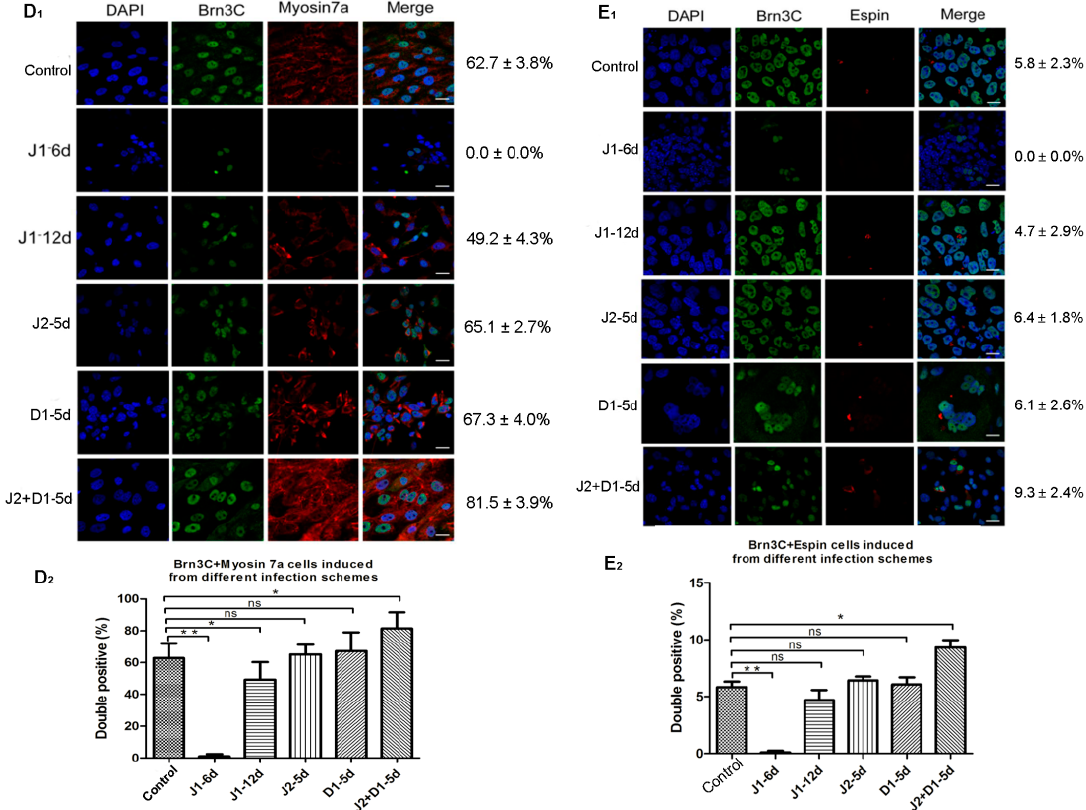
Figure 3. Analysis of hair cell- and supporting cell-specific markers in cells from six infection schemes. ( A ) RT-PCR analyses for the expression of markers specific for hair cells (Myosin7a, Brn3c, Atoh1, and Espin) and supporting cells (P27 kip1 ) in cells from six infection schemes. ( B ) Semi-quantitative analysis of the expression of specific genes using Image J and GraphPad. Expression values are relative to those of GAPDH and are presented as the mean ± SD ( n = 3). * indicates p < 0.05; ** indicates p < 0.01. ( C 1 ) Co-expression of Atoh1 (red) and Brn3c (green) in cells induced from six infection schemes. Scale bar: 20 µ m. ( C 2 ) Percentage of Brn3C/Atoh1 double-positive cells in total cells induced using different infection schemes. Error bars represent the SD ( n = 5). ( D 1 ) Co-expression of Myosin7a (red) and Brn3c (green) in cells induced using the six infection schemes. Scale bar: 20 µ m. ( D 2 ) Co-expression of Brn3C and Myosin 7a in total cells induced using the different infection schemes. Error bars represent the SD ( n = 5). ( E 1 ) Co-expression of Espin (red) and Brn3c (green) in cells induced using the six infection schemes. Scale bar: 20 µ m. ( E 2 ) Percentage of Brn3C/Espin double-positive cells in total cells induced using the different infection schemes. Error bars represent the SD ( n = 5). Control: cells infected by lentivirus with NC-shRNA on day 6 of otic progenitor differentiation; J1-6d/J1-12d: cells infected with lentivirus harboring JAG-1-shRNA2 at day 6/12 of otic progenitor differentiation and harvested for analysis at day 20 of hair cell differentiation; J2-5d/D1-5d/J2+D1-5d: cells infected with lentivirus harboring JAG-2-shRNA4/DLL-1-shRNA3/JAG-2-shRNA4 + DLL-1-shRNA3 at day 5 of hair cell differentiation and harvested for analysis at day 20 of hair cell